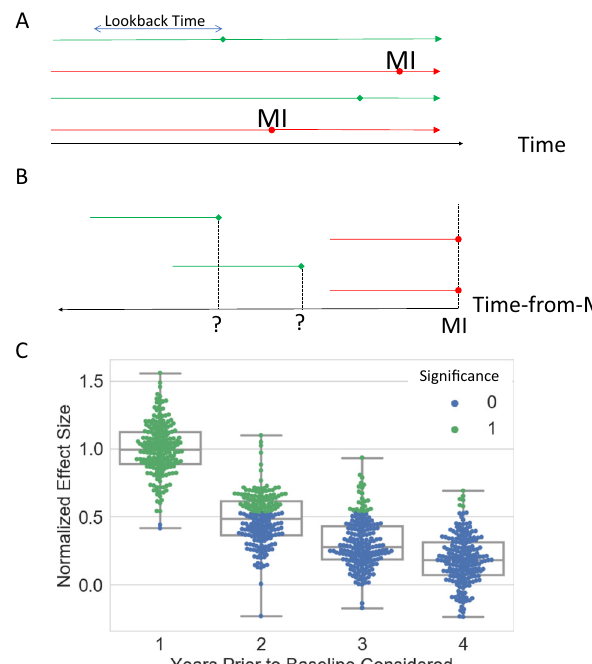
Fig. 3 Temporal bias results from arbitrary alignment of cases and future-indexed lookback times. A Over a particular time period, longitudinal data of olive oil consumption is continuous for all cohort members with time. Circles represent MI events, while diamonds represent matched, but otherwise arbitrarily chosen baseline points for controls. B Case-control studies arbitrarily align MI patients at the date of the MI. As a result, the time dimension is inverted and anchored to the MI date, the position of controls is consequently lost. C Strength of olive oil consumption-MI association given years of consumption prior to baseline considered. Effect size is normalized to the average 1-year association strength. Points are colored based on statistical signi fi cance after FDR correction. Each box plot represents 200 repeated trials. Box bounds represent upper quartile, lower quartile, and mean. Whiskers represent maxima and